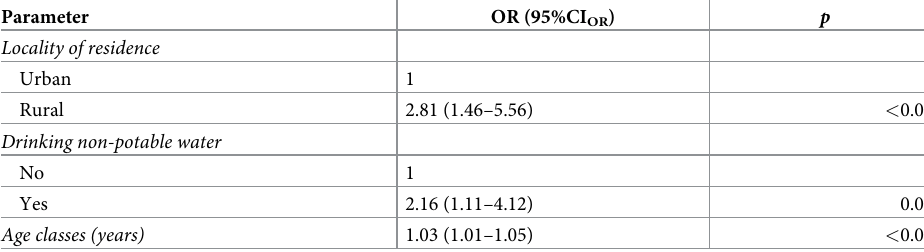
Table 3. Multivariate logistic regression model of risk factors for abdominal cystic echinococcosis in screened subjects from localities of the Monte Patria municipality, Limarı´province, Coquimbo region, Chile.